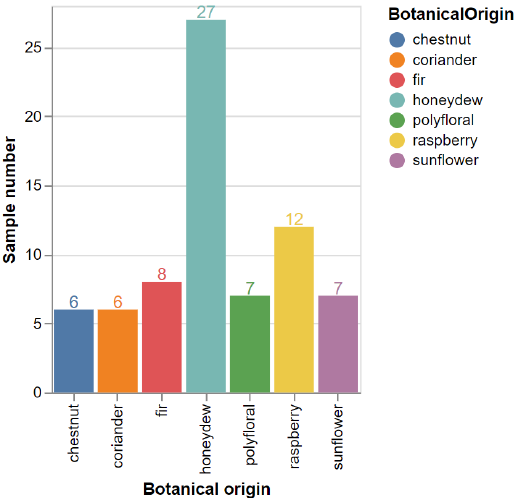
Figure 1. Histogram representing the botanical distribution of the honey